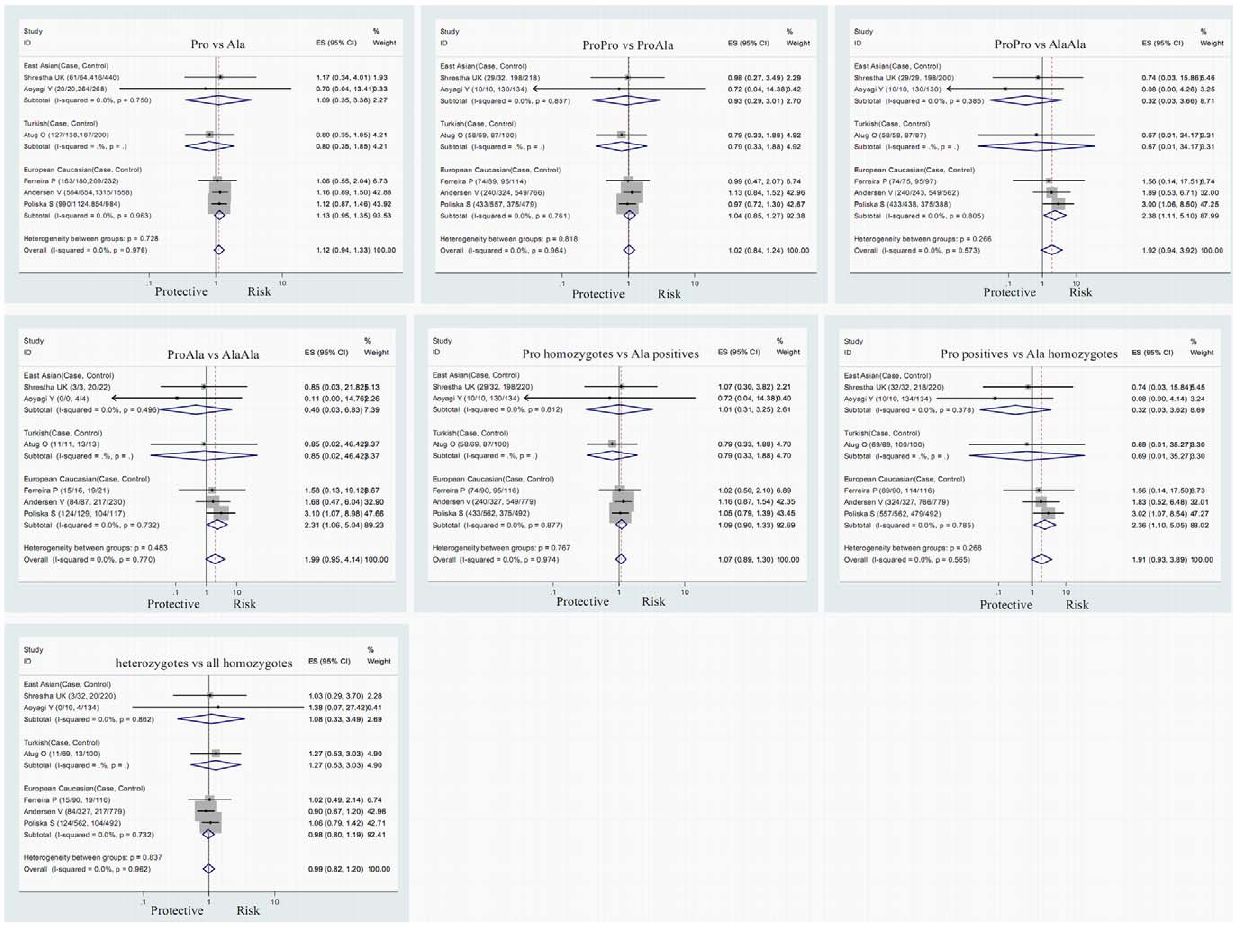
Figure 3. Forest plots for meta-analyses of the association between the PPAR c Pro12Ala mutation and the presence of CD.